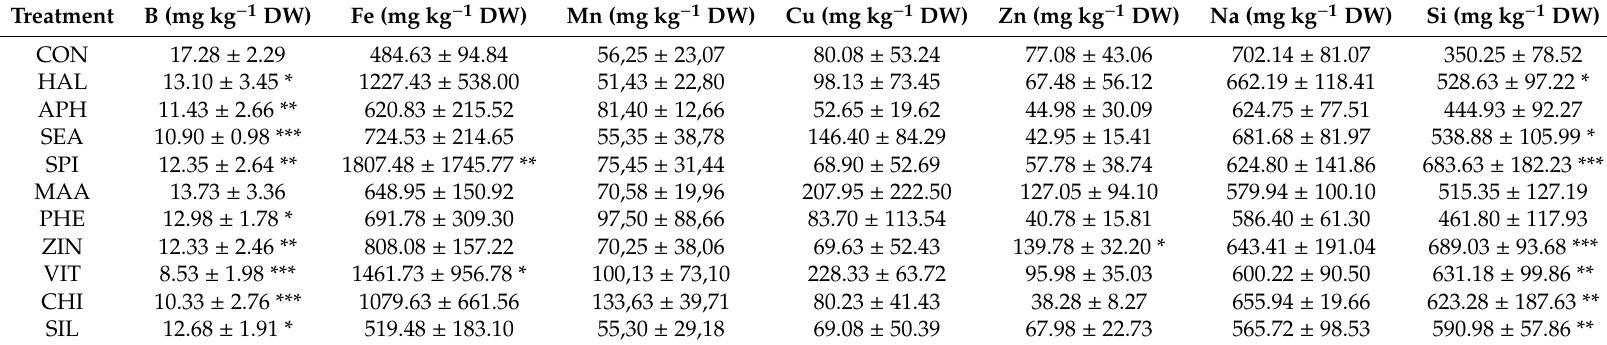
Table 8. Micronutrient concentrations in strawberry roots at 90 DAT (days after transplanting) as a ff ected by biostimulant application.